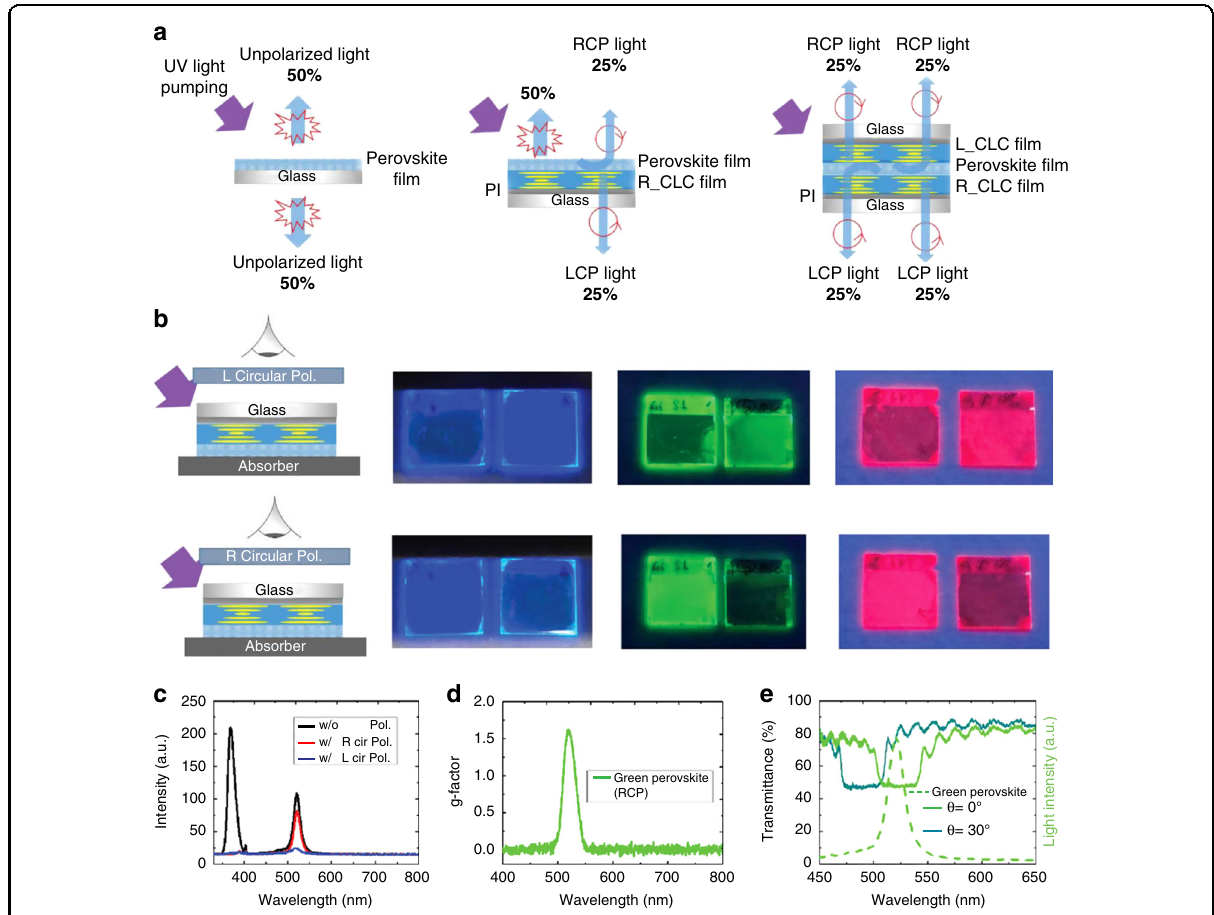
Fig. 10 Chiral perovskite nanocrystals based on chiral liquid-crystalline template. a The principle of CPL induced by the cholesteric superstructure. b Photographs of liquid crystal-templated chiral perovskite fi lms observed through a right-handed circular polarizer and a left-handed circular polarizer, respectively. c Luminescent spectra for chiral perovskite fi lm exhibiting green luminescence probed with and without the polarizer. d g -factor for right-handed CPL from green chiral perovskite fi lm. e The emission spectrum of a green chiral perovskite fi lm and the re fl ection spectra of chiral liquid-crystalline fi lm observed at 0° and 30° viewing angle. Reproduced with permission from ref. 270 . Copyright 2019,